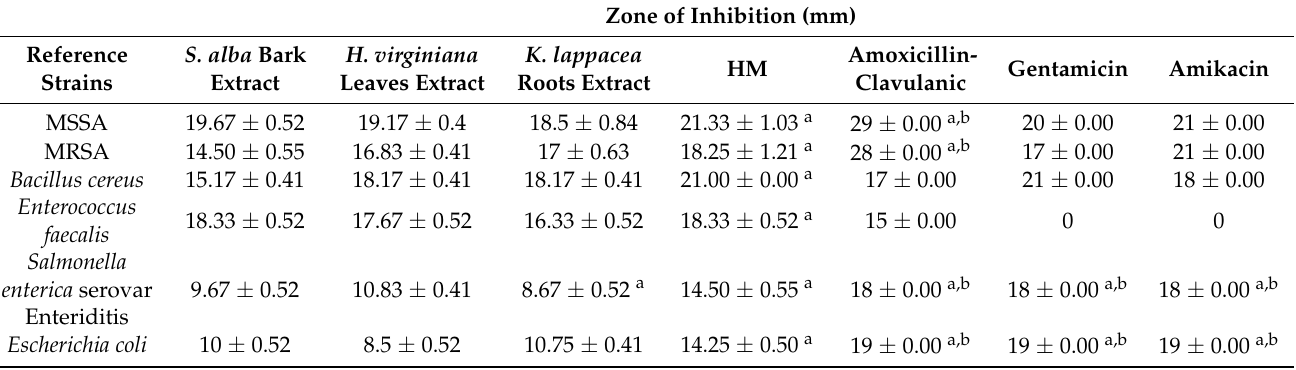
Table 2. In vitro antibacterial activity of the individual extracts and of the HM (agar well-diffusion assay). Zone of Inhibition